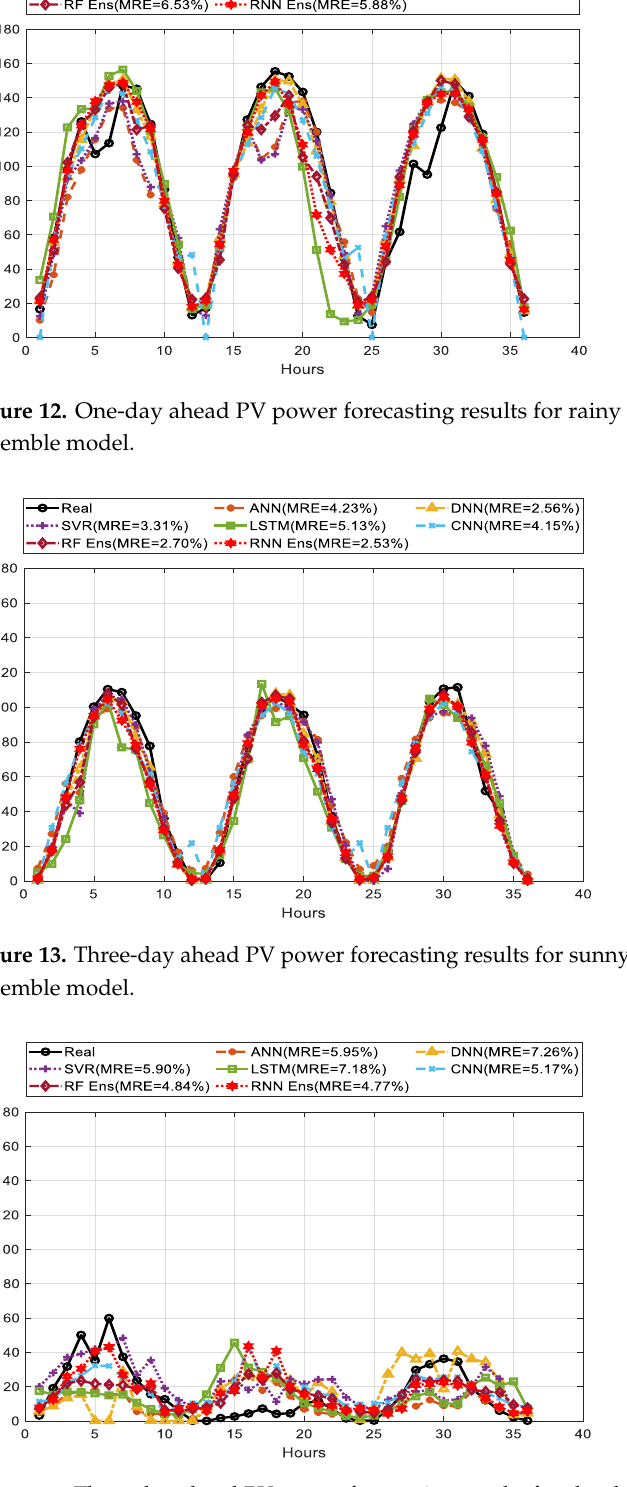
Figure 15. Three-day ahead PV power forecasting results for rainy days between single model and ensemble model.